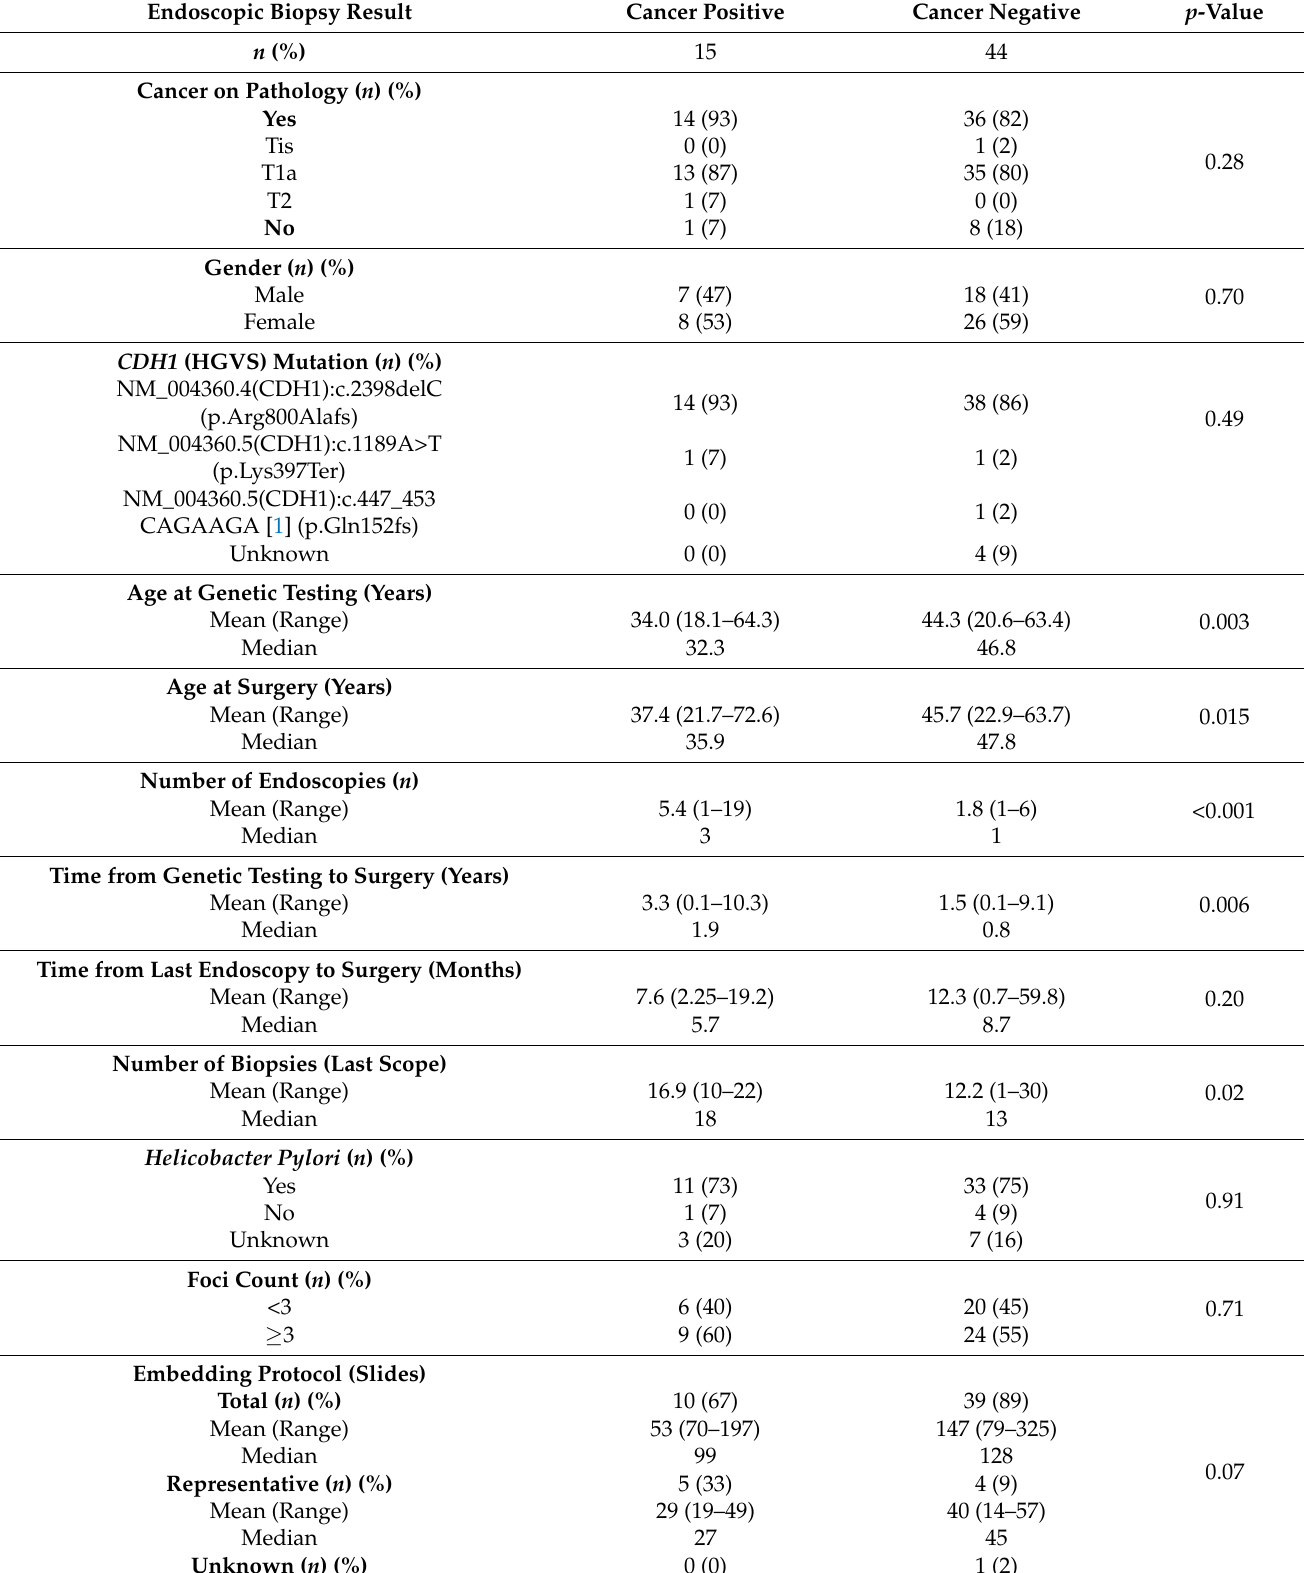
Table 3. Overview of correlation of endoscopic biopsy results to final PTG specimen results in the Newfoundland and Labrador